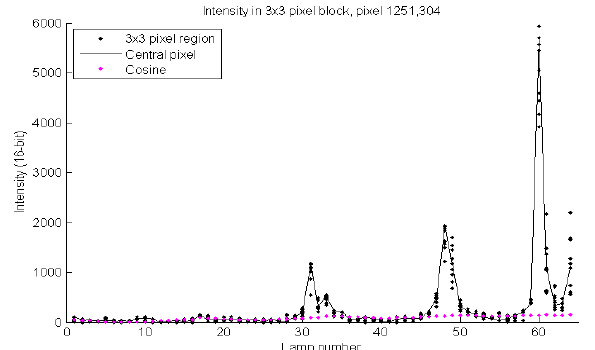
Figure 9. Actual intensity values in a 3x3 neighbourhood of a single pixel for 64 illumination directions, compared with a similarly-illuminated perfect diffuser.